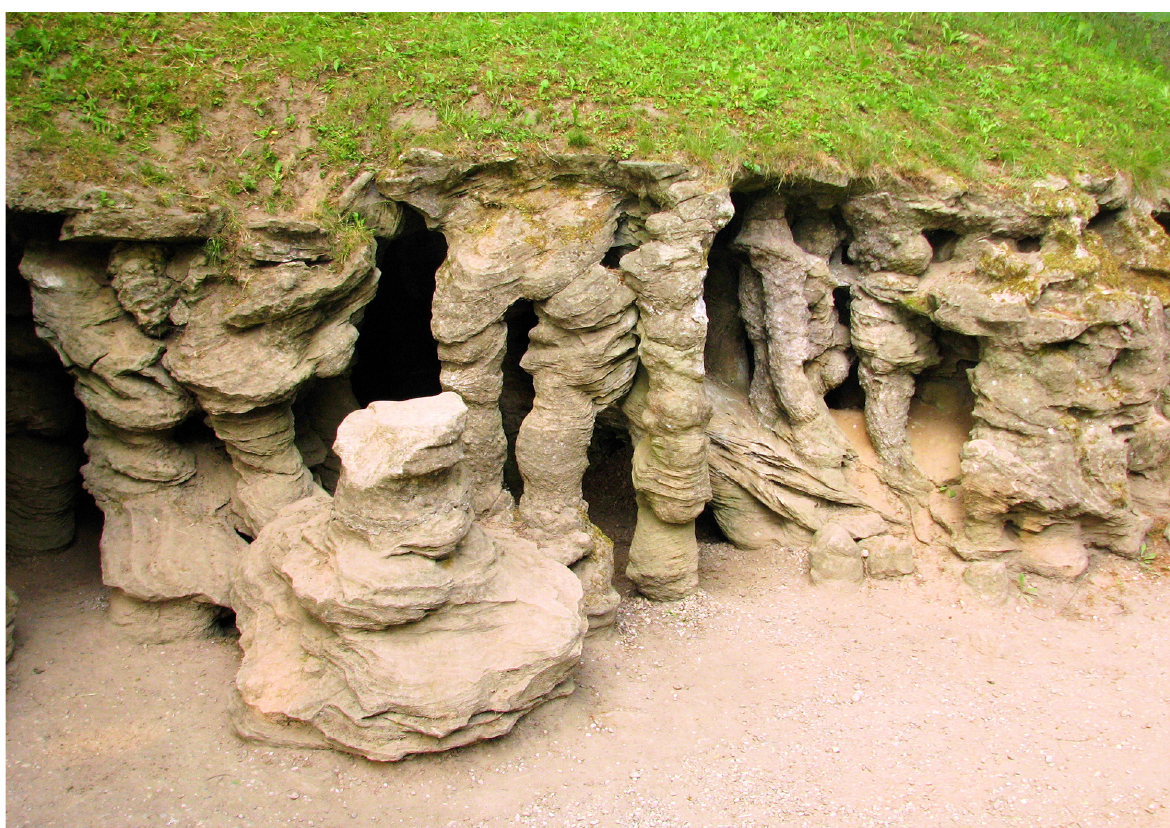
Fig. 2. Mechowo Caves’ entrance hole is formed by characteristic columns (photo: A.Marek